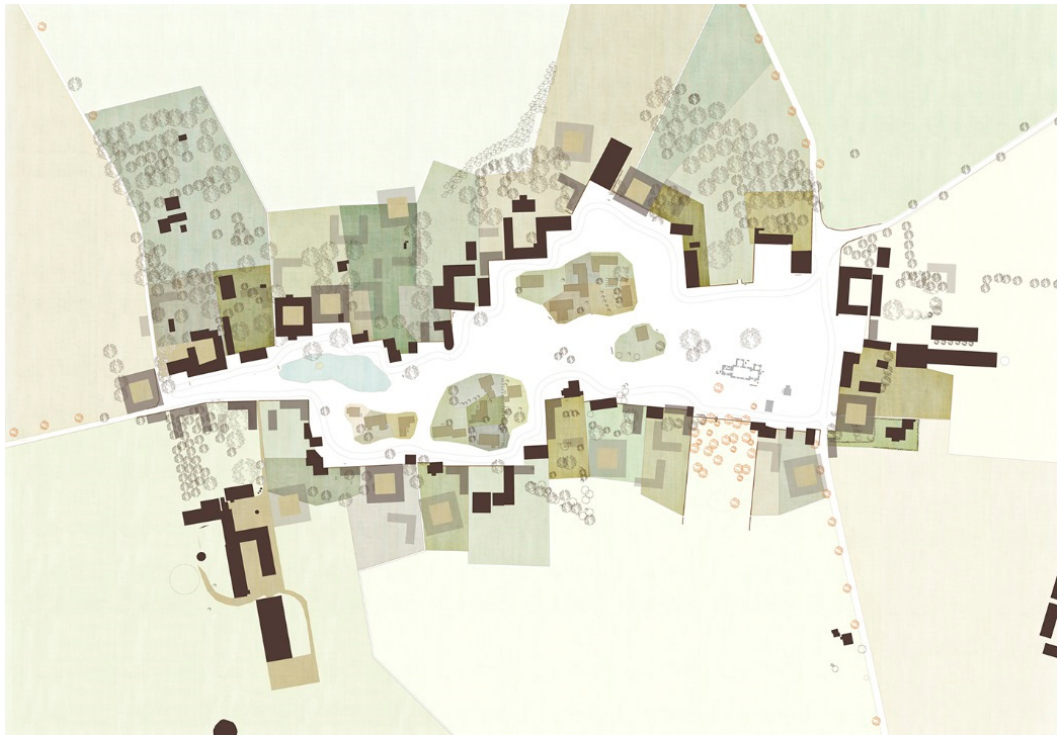
Figure 14. Suggestion for new plan of Høve.